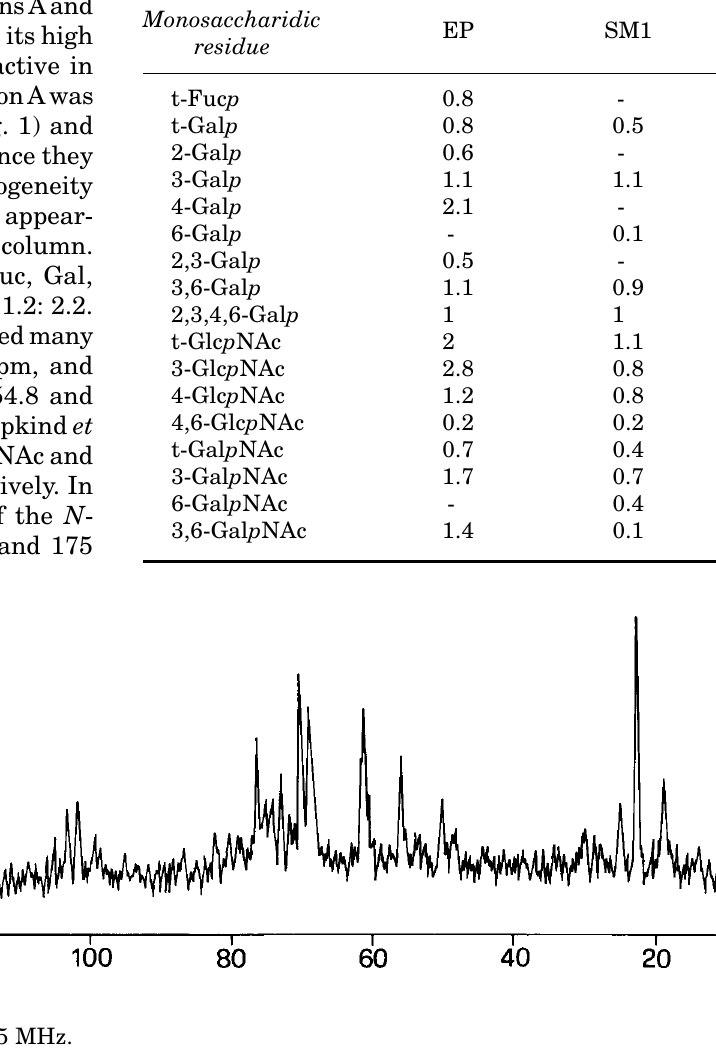
O at 62.5 MHz. 2